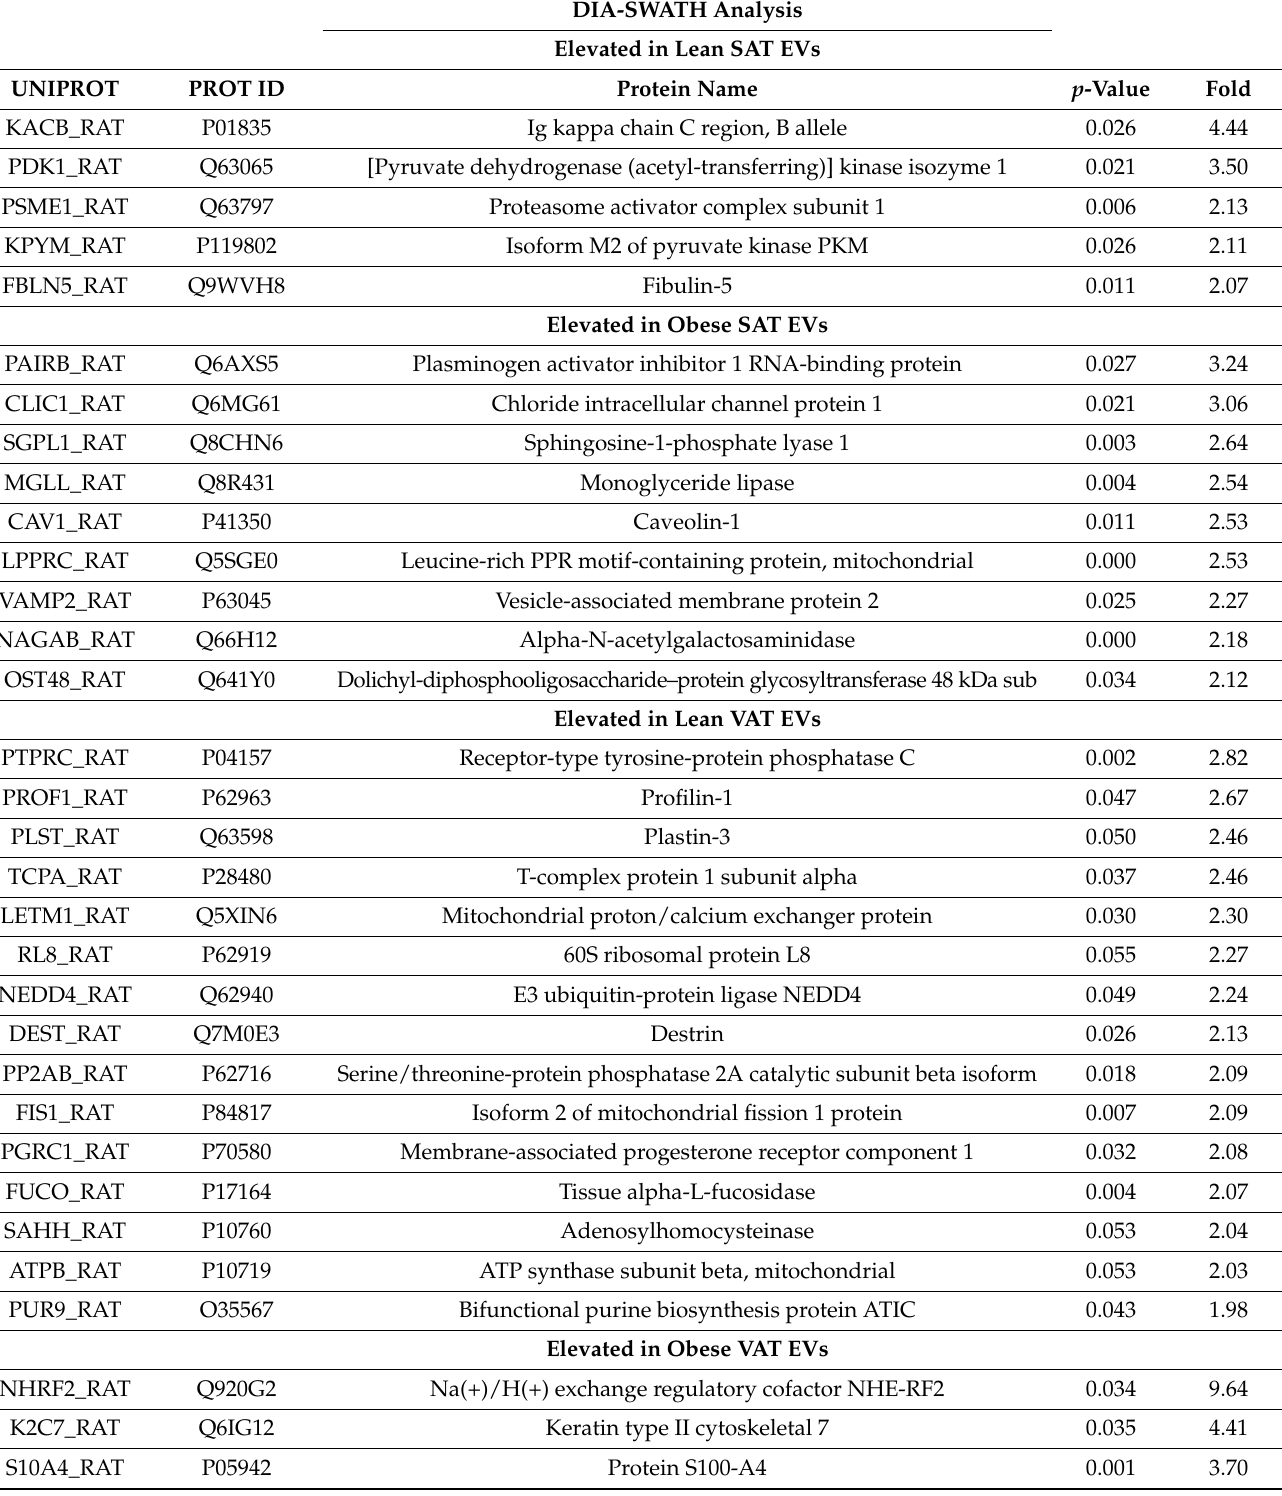
Table 1. Identified proteins by quantitative DIA-SWATH 1 analysis in EVs secreted by visceral (VAT), subcutaneous (SAT), and brown adipose BAT) tissues of lean and obese animals. DIA-SWATH Analysis Elevated in Lean SAT